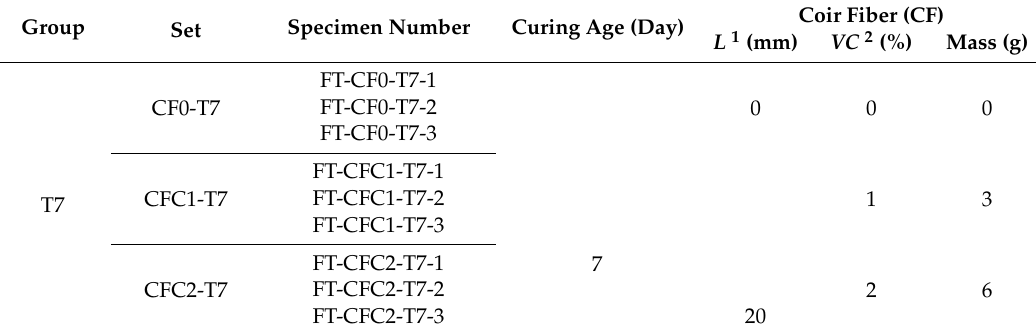
Table 1. Specimen